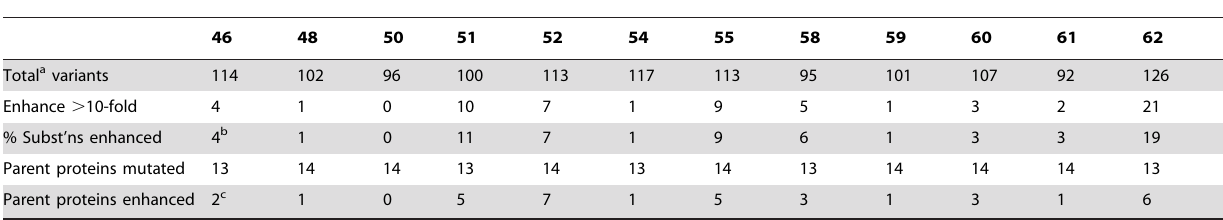
Table 3. Frequency of substitutions that enhance repression.